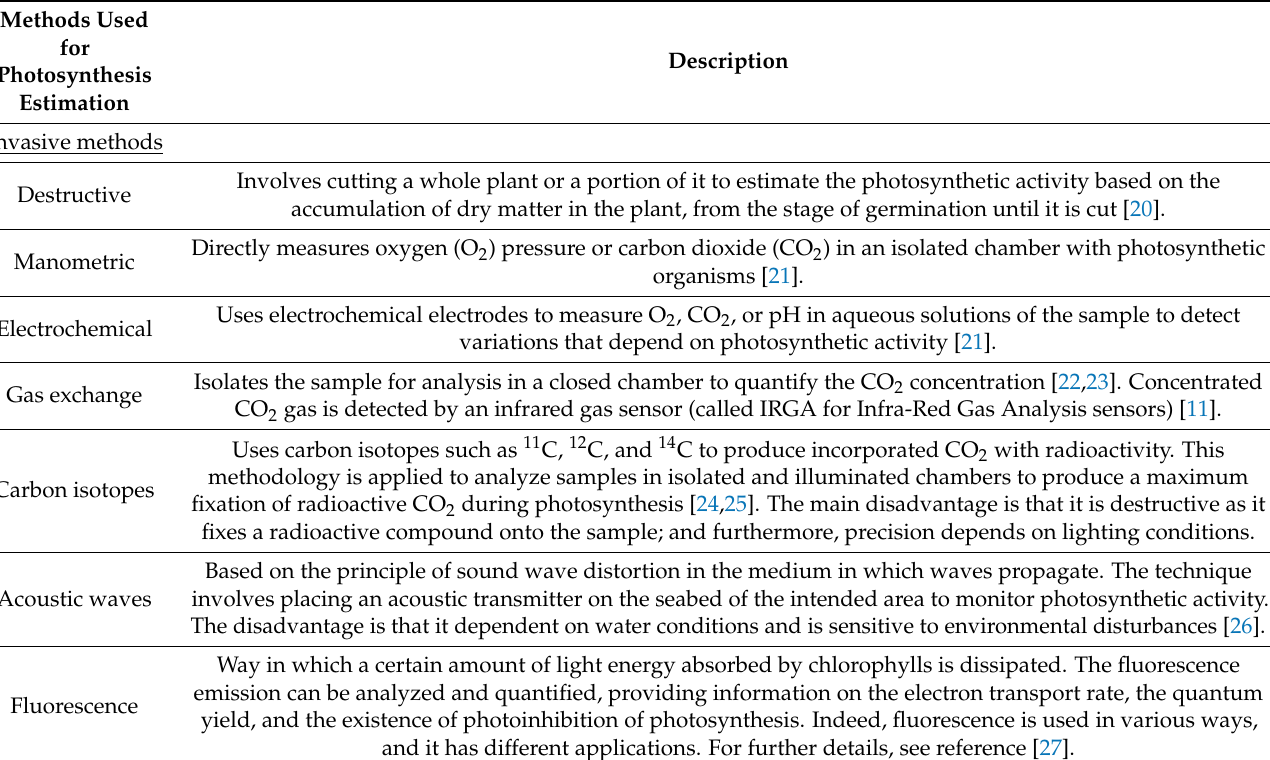
Table 2. Classification of the methods used for photosynthesis estimation and their general